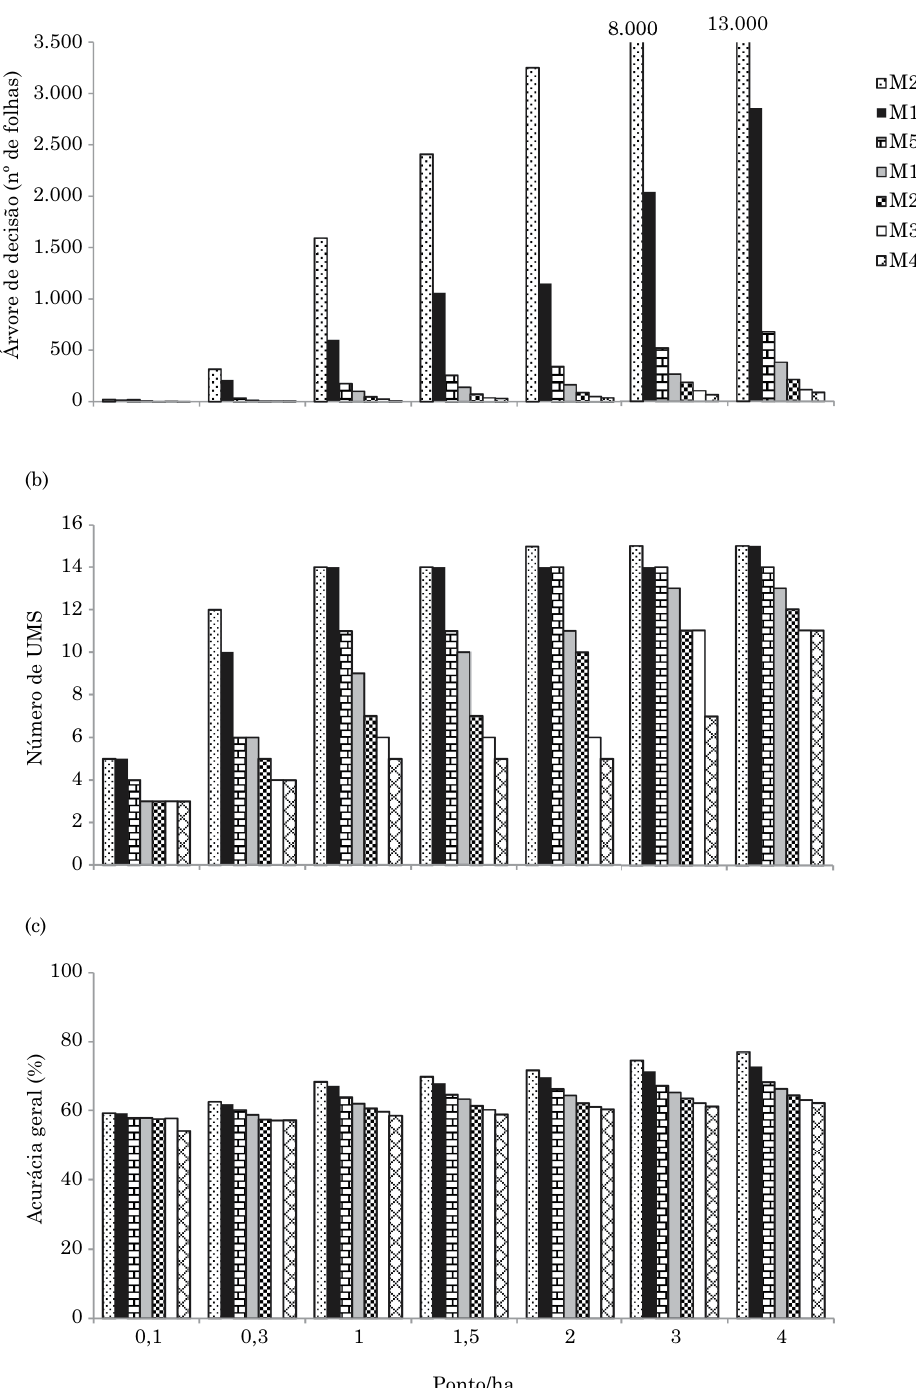
Figura 3. tamanho das árvores de decisão (a), número de unidades de mapeamento de solos preditas (UmS) (b) e acurácia geral (c) nas diferentes densidades de amostragens na bacia do rio lageado